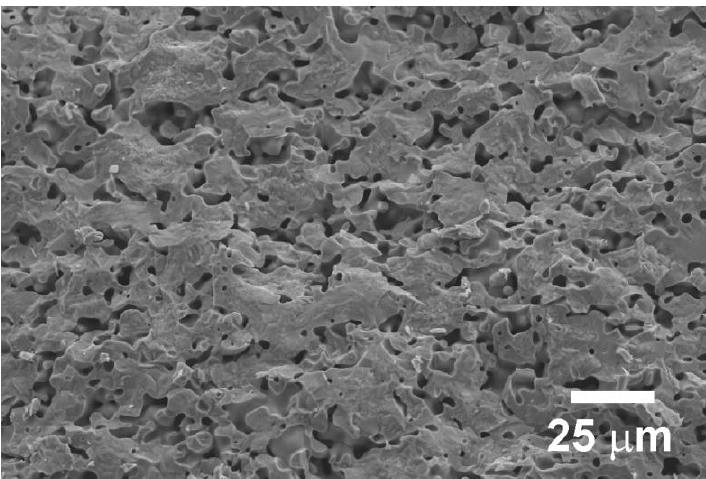
Figure 2. Representative field emission scanning electron microscope (FESEM) micrograph performed on the transversal fractured surface of Ag-free Ca 0.9 Yb 0.1 MnO 3 samples.